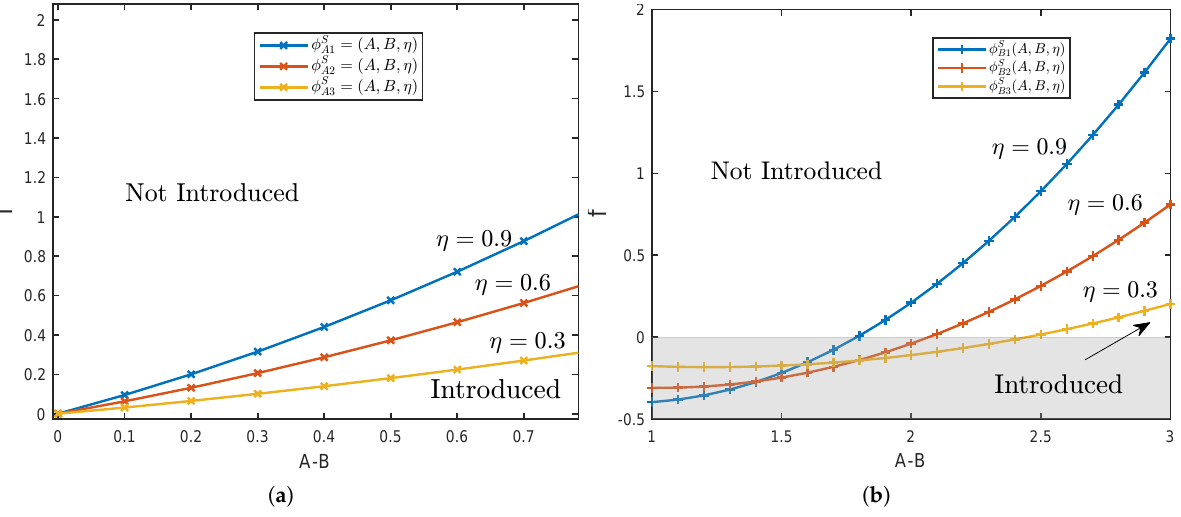
Figure 4. Optima Strategy in Single-homing Markets. ( a ) Platform A’s Optimal Strategy. ( b ) Platform B’s Optimal